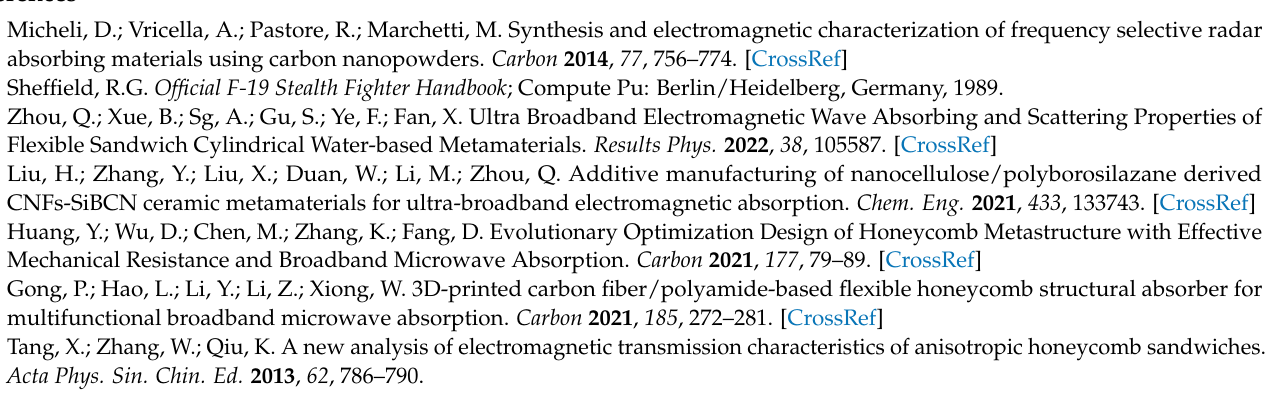
Figure 10. Simulated distributions of the power loss density of the ( a ) honeycomb core and ( b ) hon- eycomb sandwich structure.